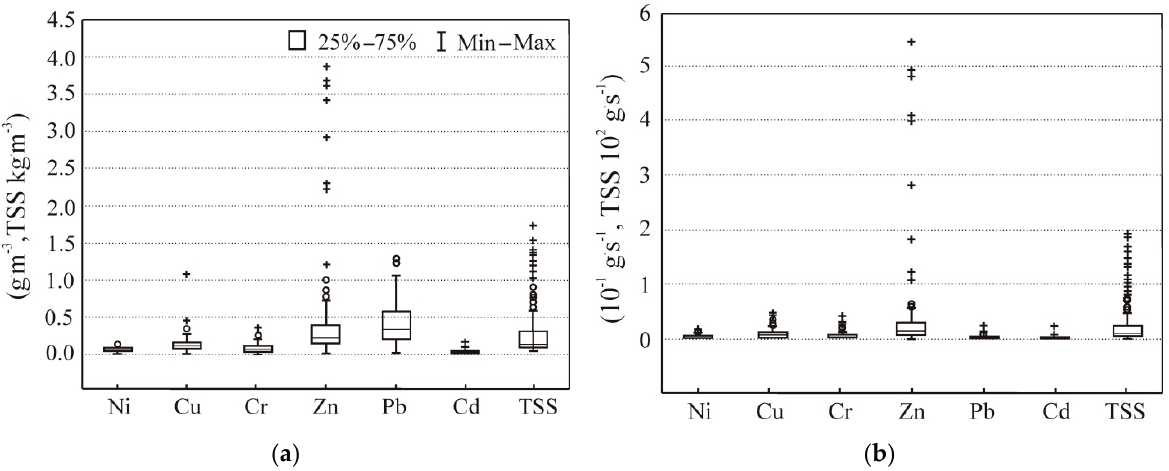
Figure 3. Box plot of TSS and HM concentration ( a ) and loads ( b ) for the studied rainfall high-water stages.